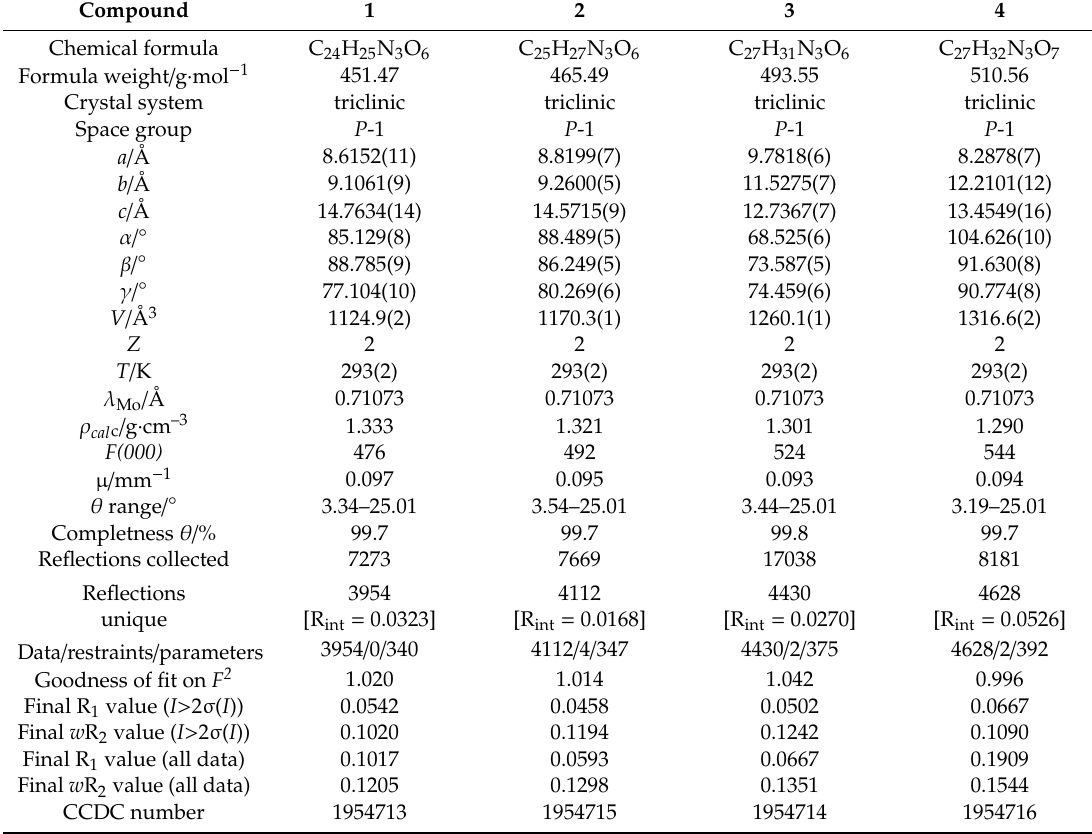
Table 1. Crystal data and structure refinement for compounds 1 –